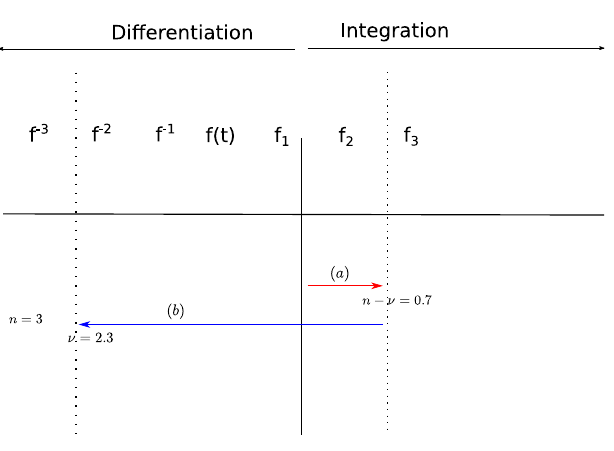
Fig. 1 Graphical Representation of Left-hand definition of fractional derivative for order ν = 2 .